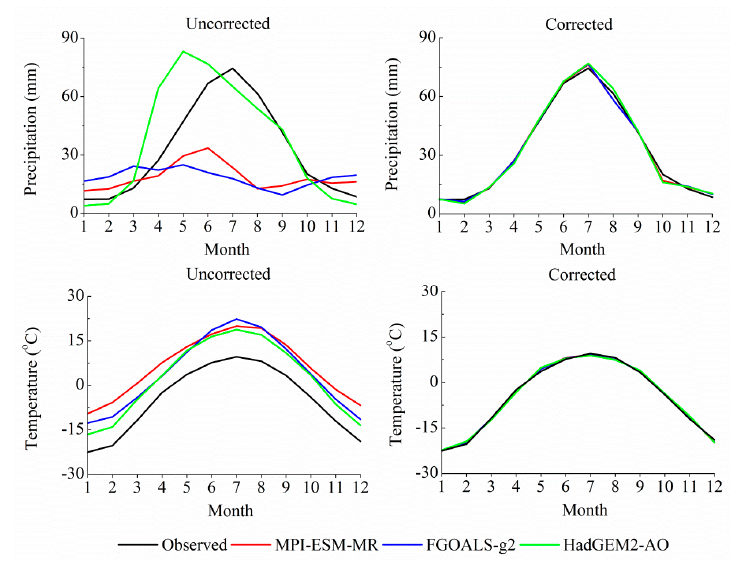
Figure 6. Average monthly precipitation and temperature data of global climate models (GCMs) before and after bias correction.